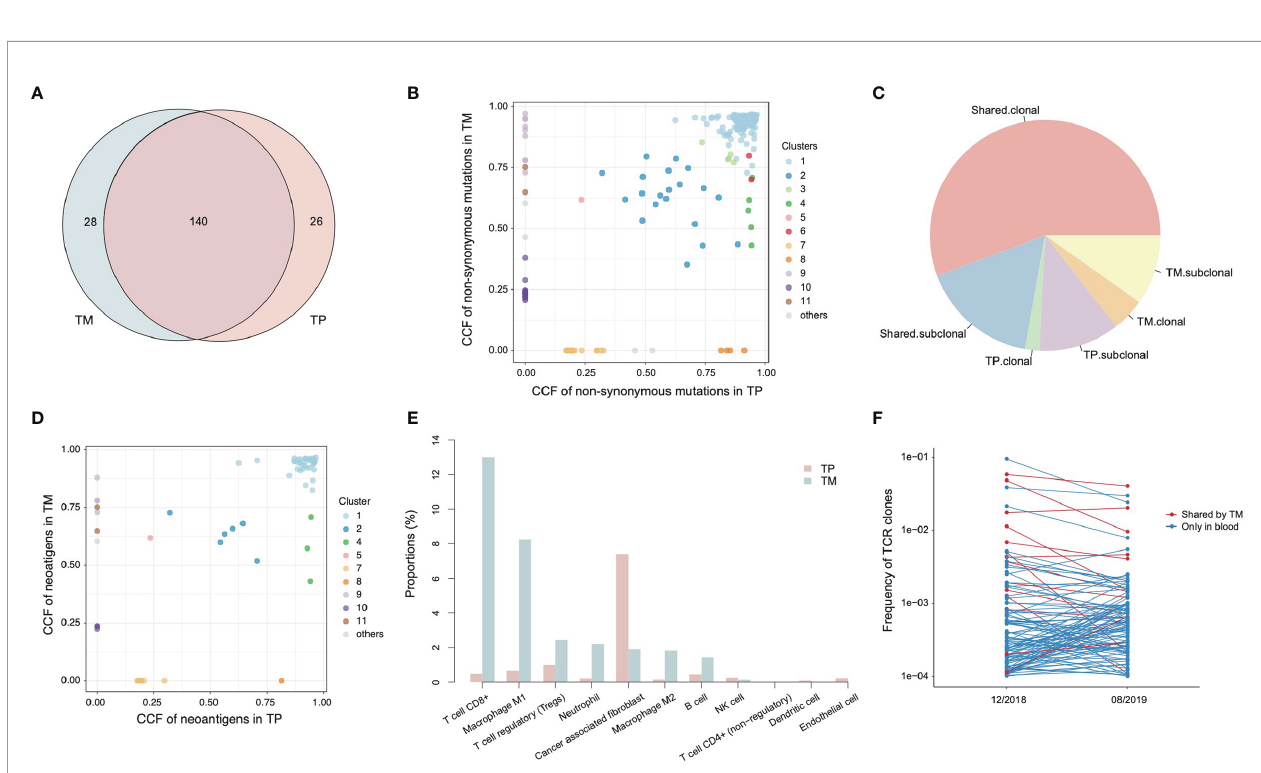
FIGURE 3 | Genetic alterations and tumor microenvironment of primary tumor (TP) and metastatic tumor (TM). (A) The Venn diagram of non-synonymous mutations detected in TP and TM. (B) The cancer cell fractions (CCF) of non-synonymous mutations detected in TP and TM. (C) The percentages of clonality of mutations. (D) The CCF of neoantigens calculated in TP and TM. (E) The proportions of in fi ltrating immune cells and stroma cells in TP and TM. (F) The frequencies of TCR clones in peripheral blood mononuclear cells (PBMCs).